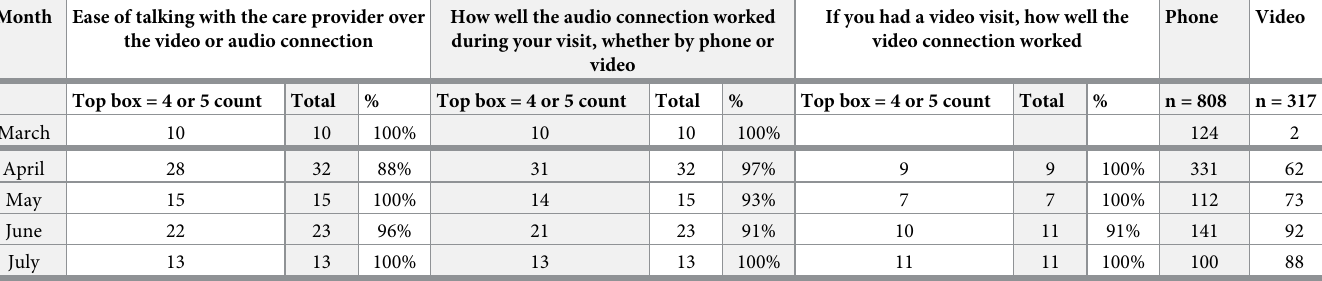
How well the audio connection worked If you had a video visit, how well the Phone Video during your visit, whether by phone or video connection worked video